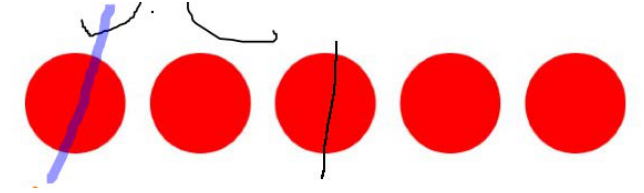
Figure 5 . Session 4: Problem 1 - The first two moves again.